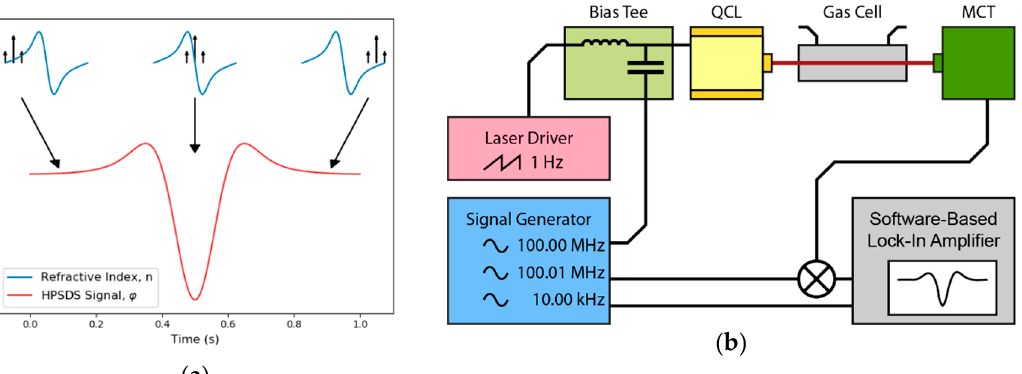
Figure 7. ( a ) The laser source is intensity-modulated and generates an optical three-tone-signal. While the laser is tuned across the absorption line, the phases of the three wavelengths are differently shifted because of the wavelength dependent refractive indices. ( b ) The detector signal is downmixed to a lower frequency and a software-based lock-in-amplifier recovers the phase information.